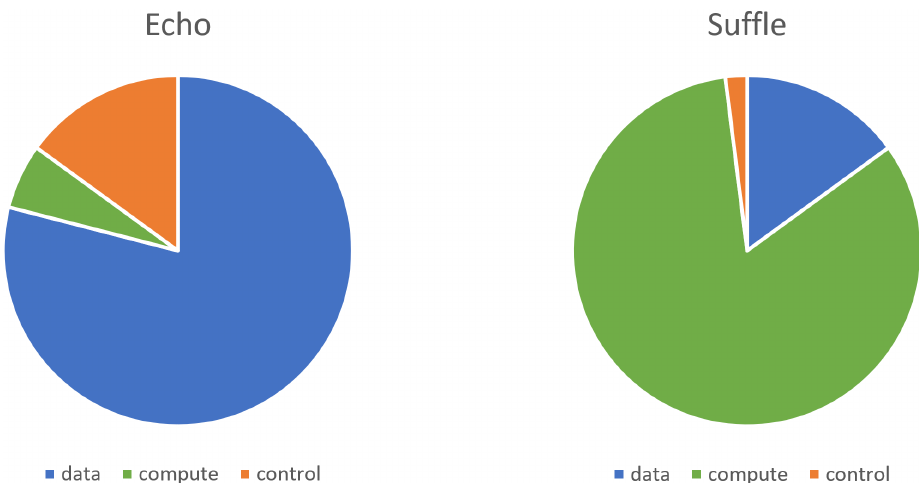
Figure 8. Time distribution for same workflow, but different steps: echo ( left ) and byte shuffle ( right